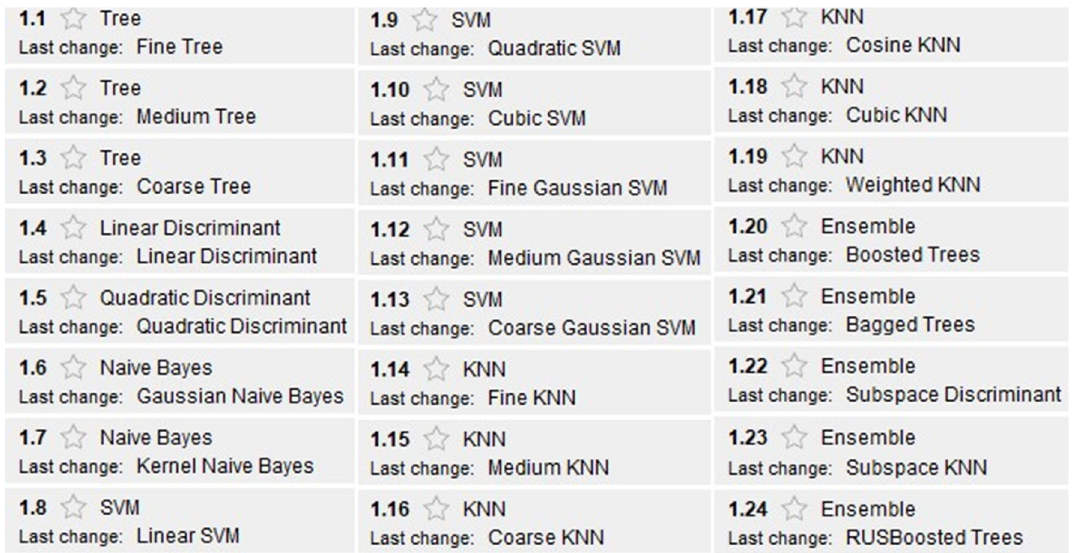
Figure 4. Compilation of classifiers used.